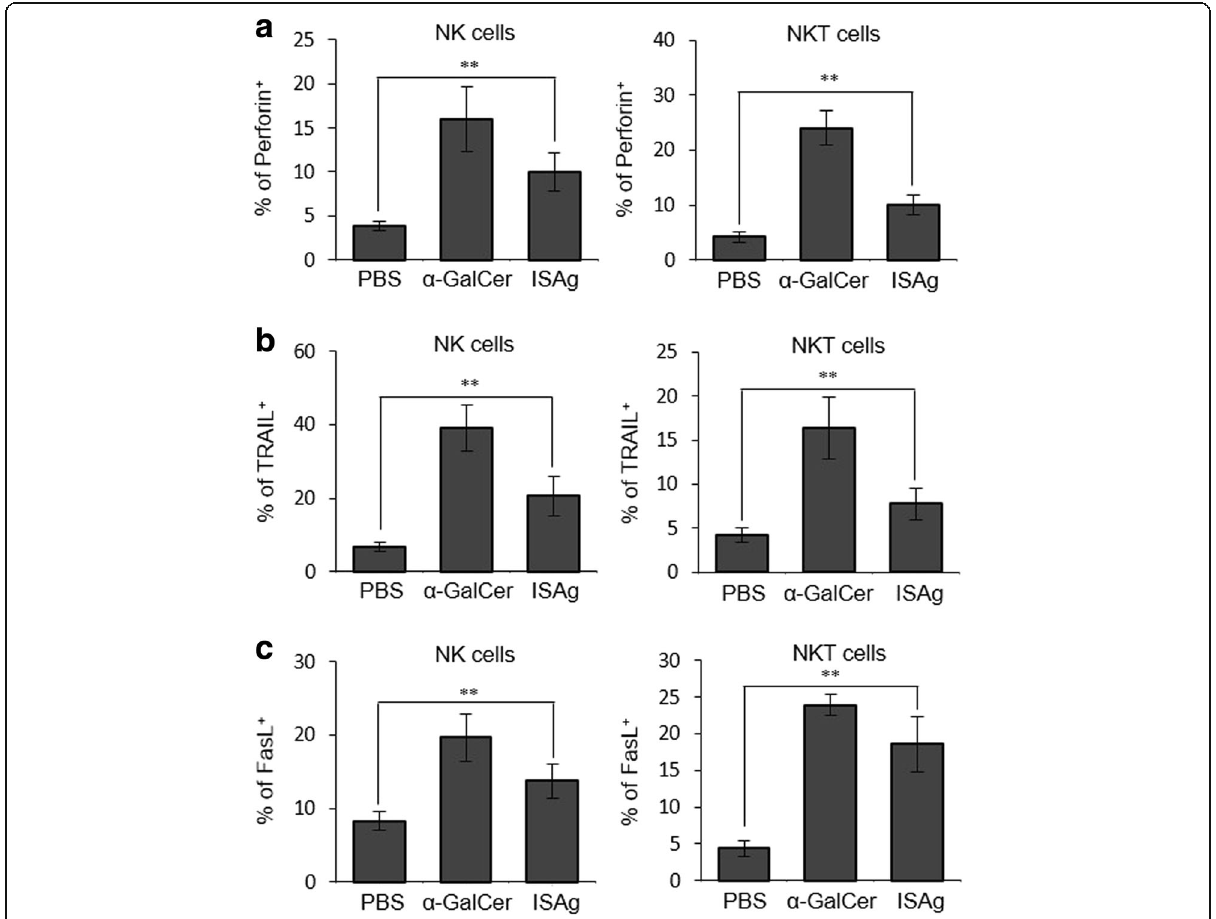
Fig. 8 ISAg induced expression of cytotoxic molecules in NK and NKT cells. The preparation of splenic NK1.1 + cells is described in the Fig. 7 legend. Expressions of ( a ) perforin, ( b ) TRAIL, and ( c ) FasL by splenic NK and NKT cells were evaluated using flow cytometry. The mean ± standard deviation values are presented (n = 5 per group; Student ’ s t-test; ** P <